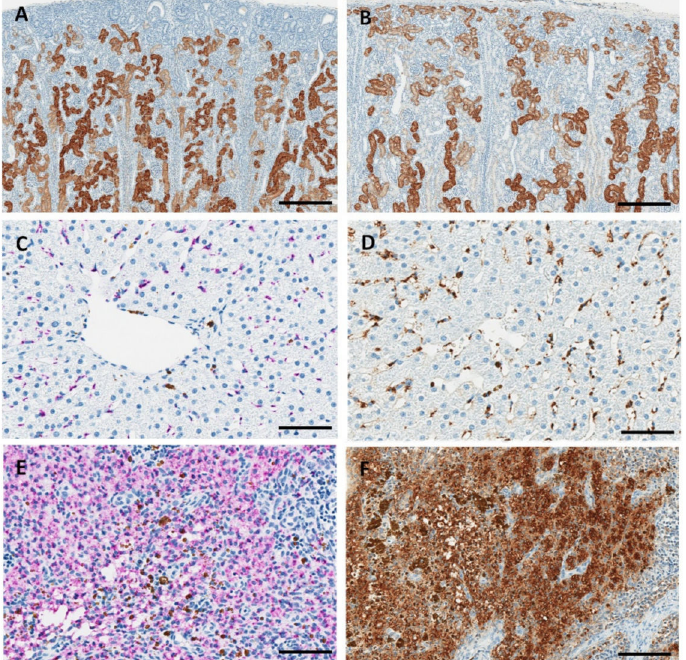
Figure 7. Immunohistochemistry and in situ hybridization. ( A ) Kidney, PND 2; immunohistochem- istry for RTR5001. Accumulation of RTR5001 into the proximal tubular cells (brown staining). Renal tubular cells of the outer cortex below the capsule are not stained. ( B ) Kidney, PND 37; immunohis- tochemistry for RTR5001. Accumulation of RTR5001 in the tubular cells including the outer cortex. ( C ) Liver, PND 51; in situ hybridization for RTR5001. Accumulation of LNA into the Kupffer cells (purple staining) and brown pigment (iron deposits). ( D ) Liver, PND 51; Immunohistochemistry for RTR5001. Presence of brown staining due to accumulation of LNA in Kupffer cells and presence of iron pigment deposits cannot be differentiated, unlike with ISH-stained sections (image C). ( E ) Lymph node, PND 43; in situ hybridization for RTR5001. Accumulation of RTR5001 into the vacuolated macrophages (purple staining) and brown pigment (iron deposits) in sinus macrophages. ( F ) Lymph node, PND 43; immunohistochemistry for RTR5001 Accumulation of RTR5001 and presence of iron pigment deposits. (Scale bar: ( A , B ) = 100 µ M; ( C – F ) = 50 µ